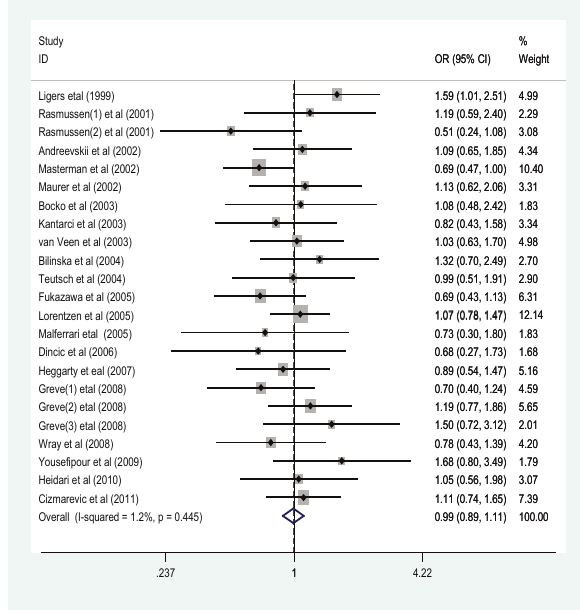
Figure 5: The forest plot of OR for CTLA-4 gene rs221775 A>G single nucleotide polymorphism and multiple sclerosis susceptibility under recessive genetic model (GG vs AG+AA)